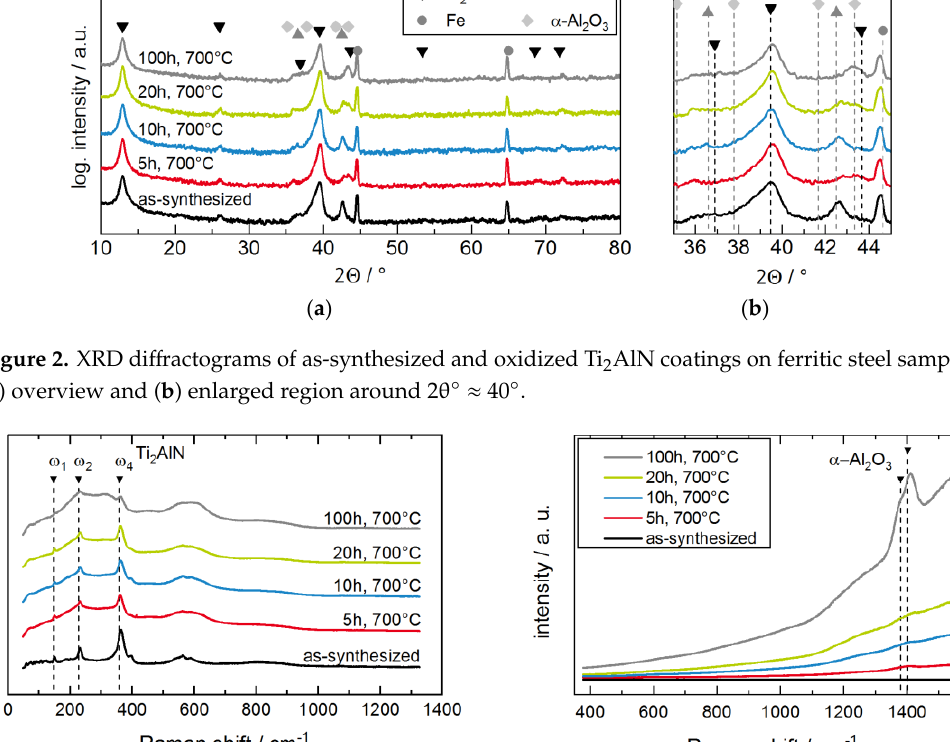
Figure 3. (a) Raman spectra ( λ Nd:YAG = 532 nm) of the Ti 2 AlN coatings before and after oxidation. (b)